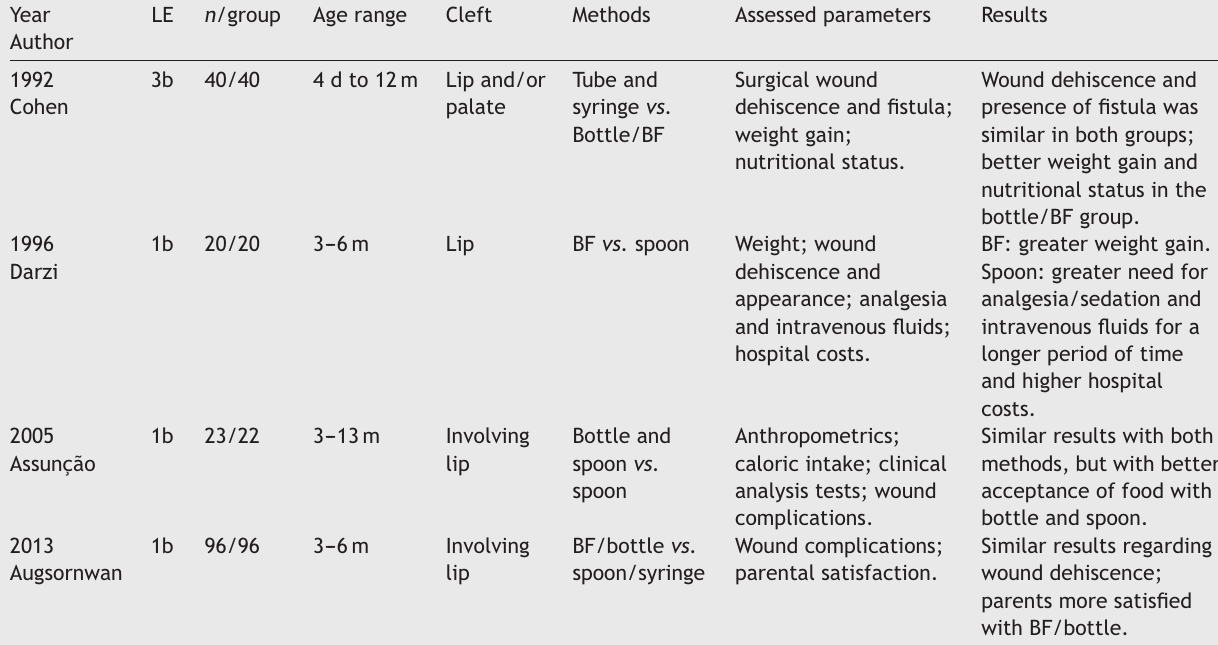
Characterization of studies comparing methods of feeding in the postoperative period of surgical repair of cleft lip and/or palate, isolated lip repair, or lip associated or not associated with